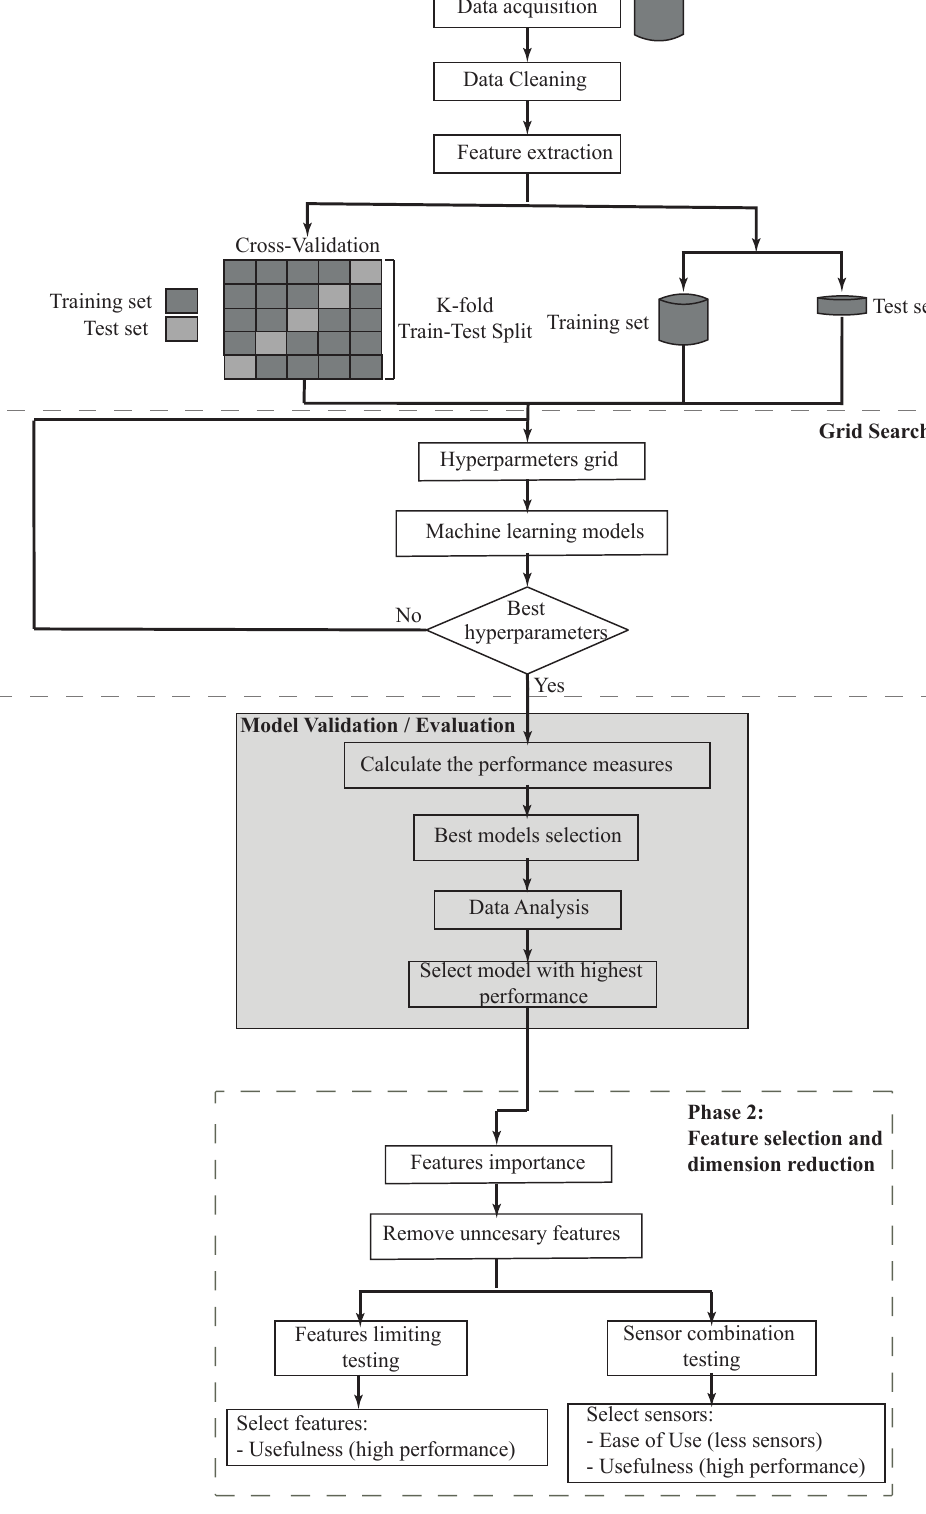
Figure 2. Flowchart that illustrates an overview of proposed